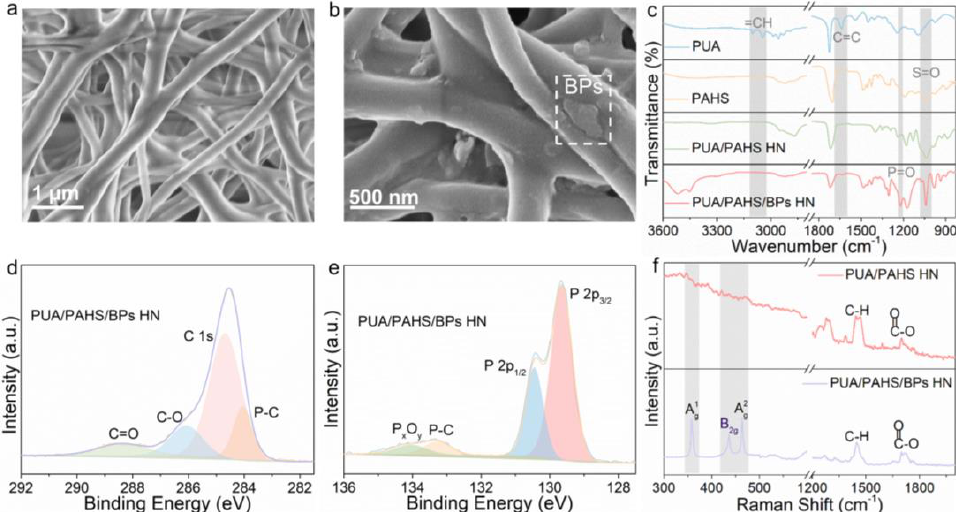
Figure 2. Characterization of BPs hybrid polymer HN coating and nonhybrid polymer HN coating. ( a ) SEM image of PUA/PAHS HN. ( b ) SEM image of PUA/PAHS/BPs HN. ( c ) FTIR spectra of PAHS, PUA, PUA/PAHS HN and PUA/PAHS/BPs HN. ( d ) HR-XPS C 1s spectrum of PUA/PAHS/BPs HN. ( e ) HR-XPS P 2p spectrum of PUA/PAHS/BPs HN. ( f ) Raman spectra of PUA/PAHS HN and PUA/PAHS/BPs HN.